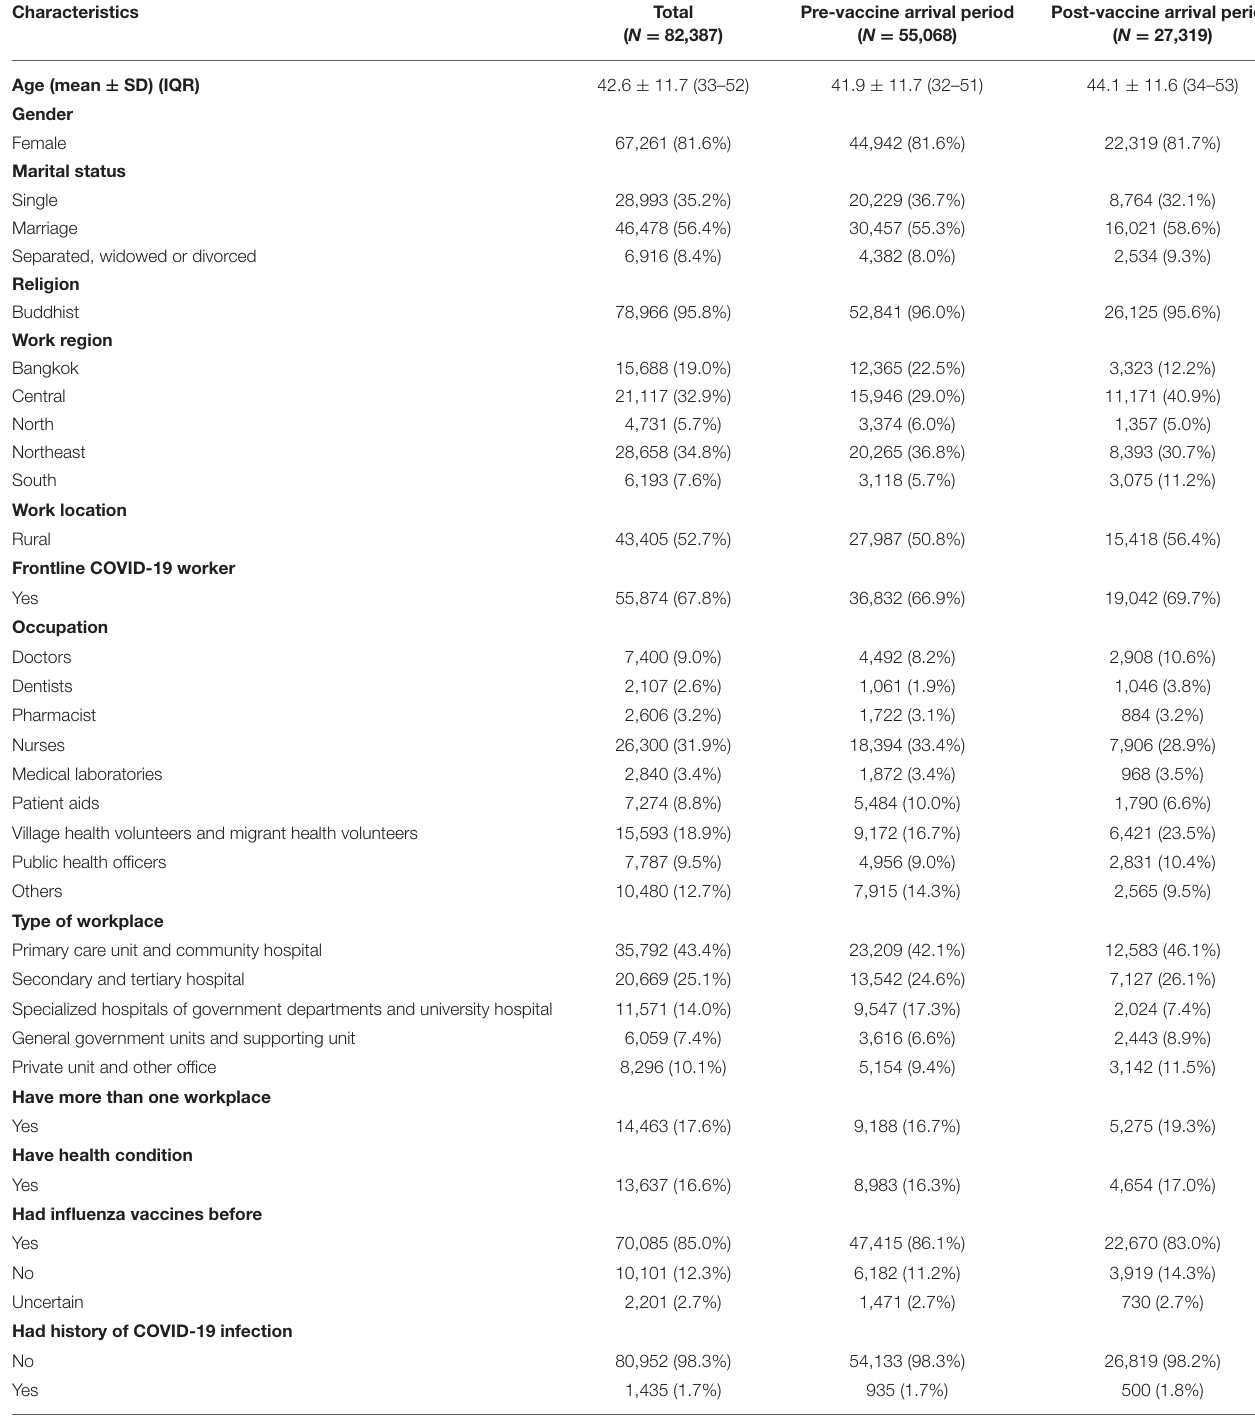
TABLE 1 | Demographic characteristics, socio-economic factors, and health-related factors of the study population and by time period.